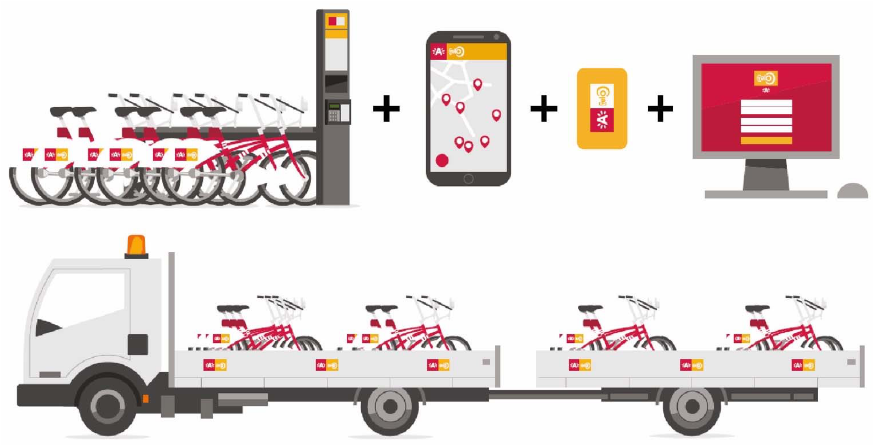
Figure 1. A product–service system (PSS) example, velo Antwerpen (courtesy to Vancoppenolle W., APBClass, 2019).